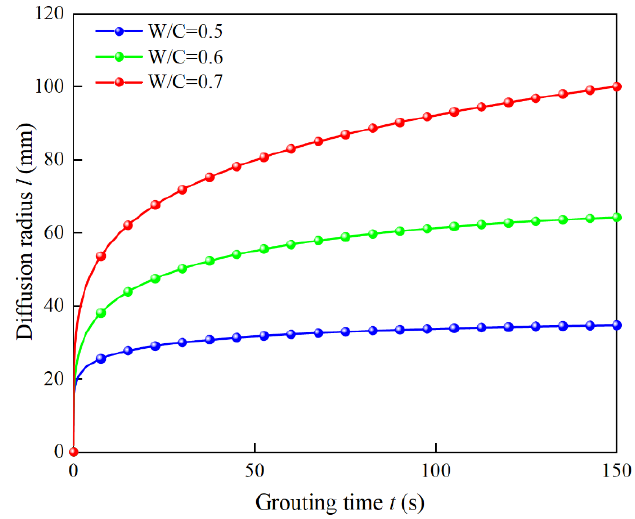
Figure 9. Influence of the water–cement ratio of the slurry on the diffusion radius.